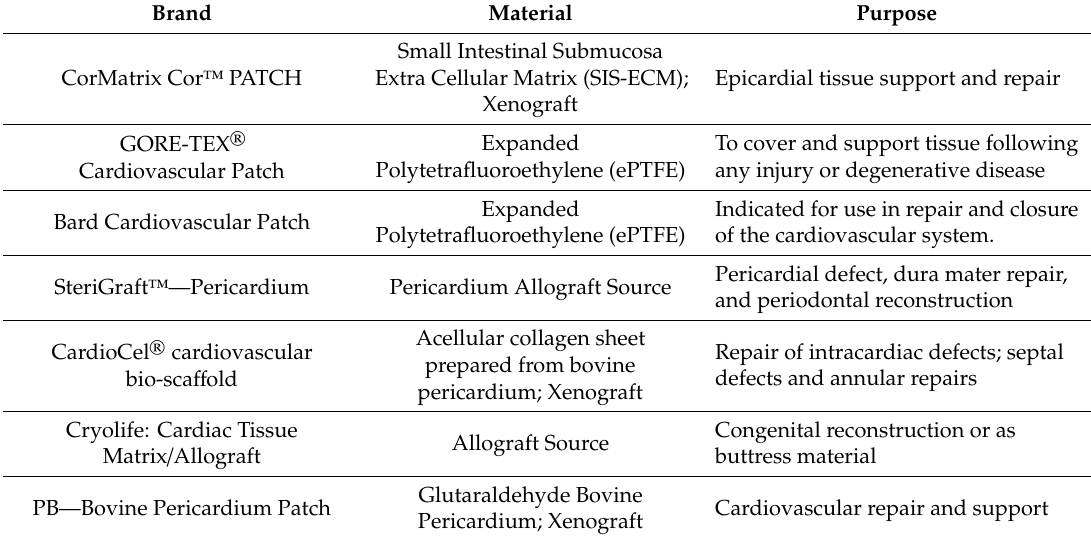
Table 3. List of the brand, material and purpose of commercially available cardiac patches. Brand Material Purpose Small Intestinal Submucosa CorMatrix Cor ™ PATCH Extra Cellular Matrix (SIS-ECM); Epicardial tissue support and repair Xenograft Expanded To cover and support tissue following Polytetrafluoroethylene (ePTFE) any injury or degenerative disease Expanded Indicated for use in repair and closure Polytetrafluoroethylene (ePTFE) of the cardiovascular